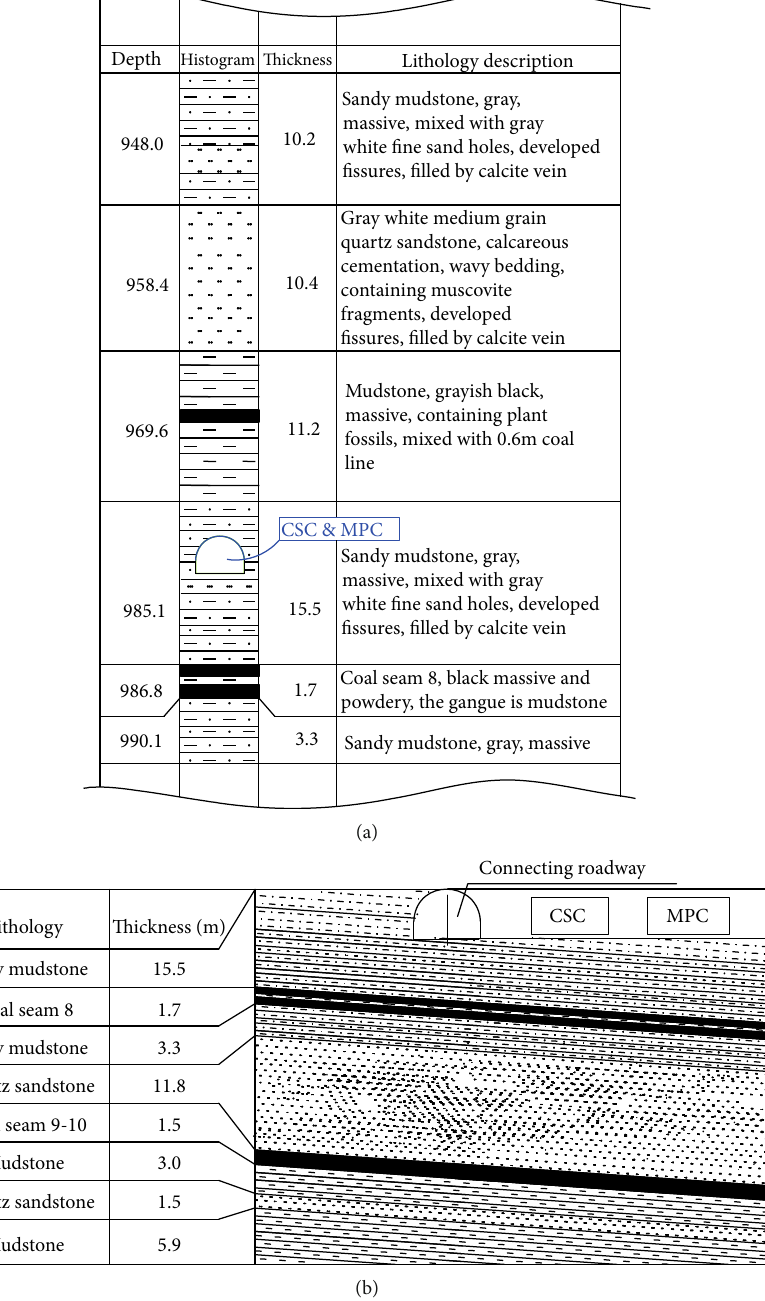
Figure 1: (a) Stratigraphic histogram of CSC and MPC. (b) Schematic diagram of fl oor strata of CSC and